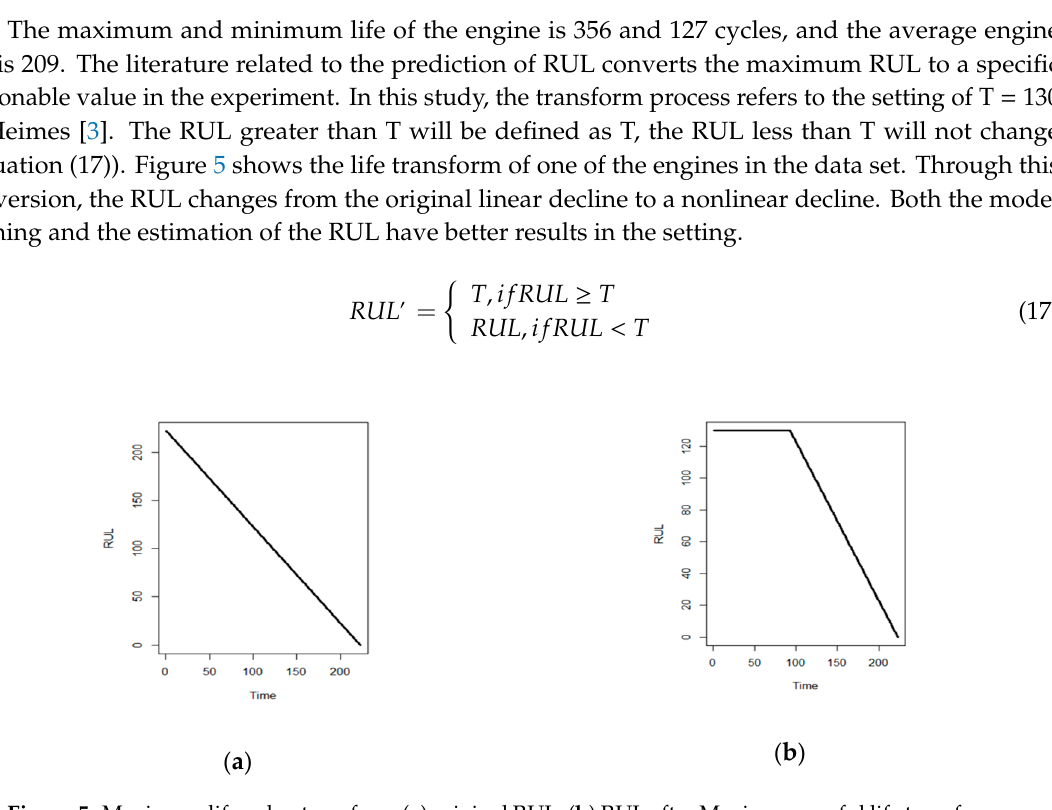
Figure 5. Maximum life value transform ( a ) original RUL; ( b ) RUL after Maximum useful life transform.